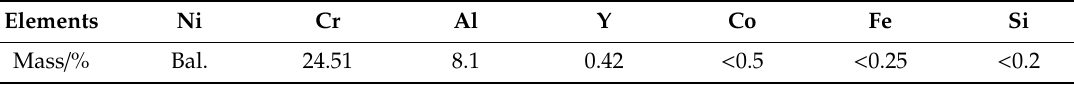
Table 1. Chemical composition of NiCrAlY alloy powder for bond